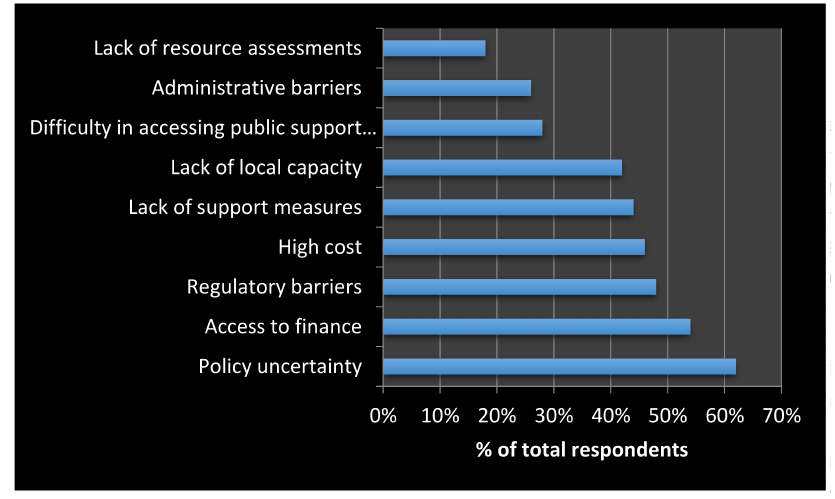
Figure 2. Barriers to mini-grid development. Source: